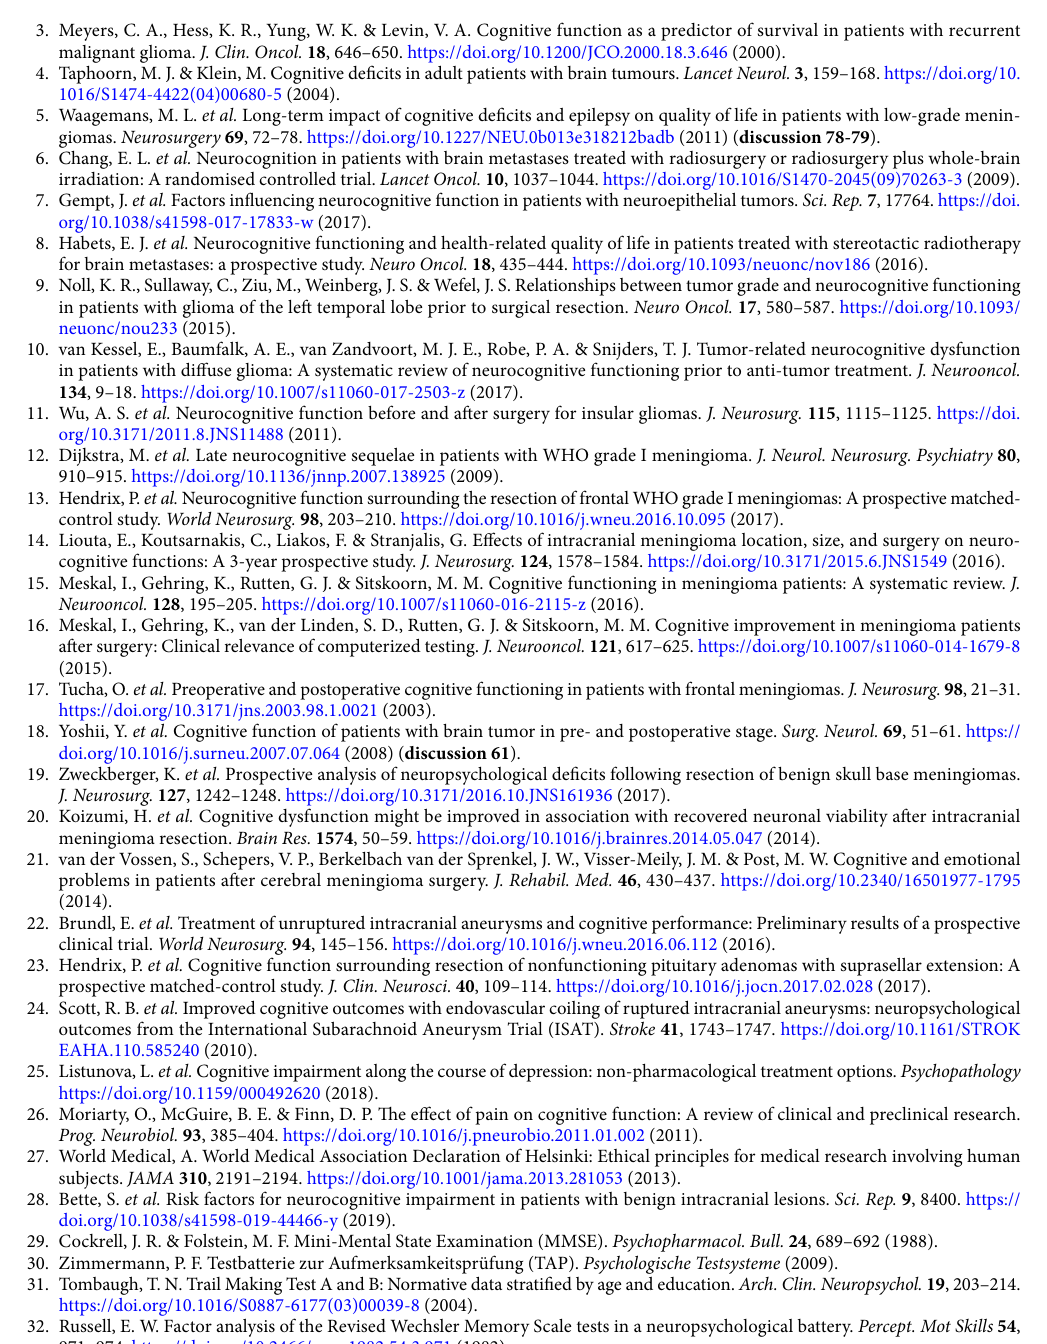
Figure Test. Nat. Protoc. 1 , 892–899. https:// doi. org/ 10. 1038/ nprot. 2006. 115 (2006). 34. Lange, K. W., Aschenbrenner, S. & Tucha, O. Regensburg Word Fluency Task: A new test for the assessment of verbal fluency.